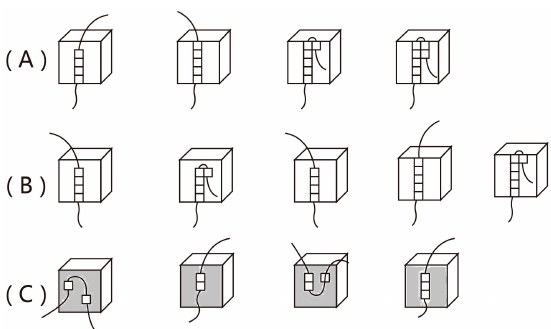
Figure 6. Schematic diagram of some typical microscopic models: ( A ) The fine-grained model proposed by Frank and Tosi. At each step, a unit or segment rather than a stem will be added on the crystal front, and the units can only fluctuate on and off along the direction of lamellar thickness. Chain folding is inaccessible before the cumulative length of units reaches the lamellar thickness. ( B ) Point’s multi-path approach allows chain folding at each step. In addition, the pinning point is adjacent to the pre-existing units, which is energetically favorable. ( C ) The Sadler–Gilmer model. The shadow area means that the crystal front is atomically rough, while the crystal fronts of (A) and (B) are atomically smooth; therefore, the deposition of units on the rough surface is not necessarily adjacent to each other (in order to minimize the exposed areas) and the barrier is entropic origin.